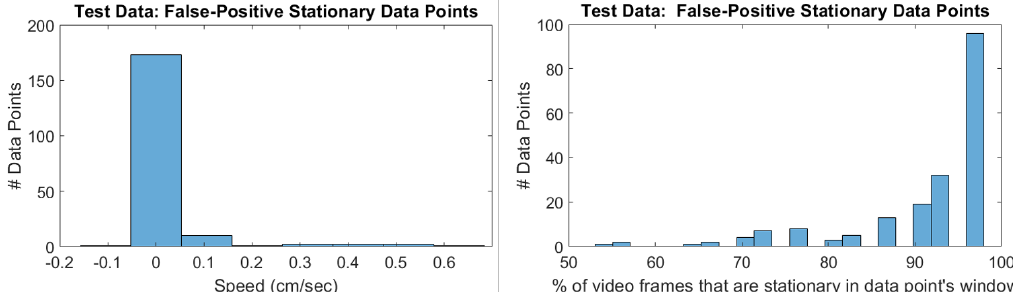
Figure 12. Speed Distribution of False-Positive Stationary Samples: ( Left Plot ) Ground truth speeds for samples falsely flagged as stationary. Bin width of 0.1 cm/s. ( Right Plot ) Percentage of video frames that are labeled as stationary in false positive data points. Bin width of 2%. Many false-positives are caused by data points that have most, but not all, of their video frames flagged as stationary—altering the video frame threshold in the stationarity detector would resolve this